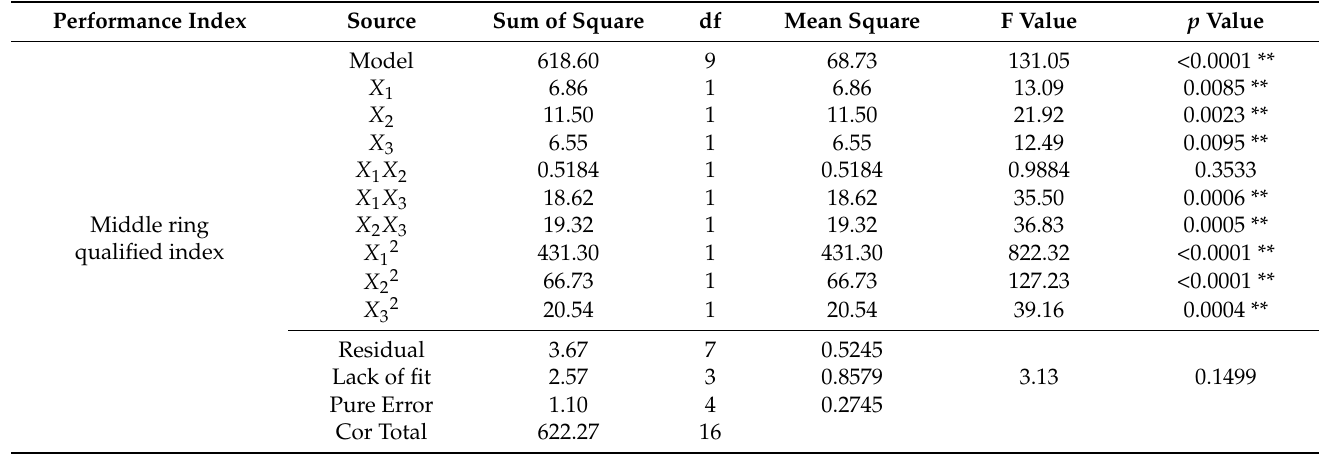
Table 5. Variance Analysis result of middle ring seed-metering performance